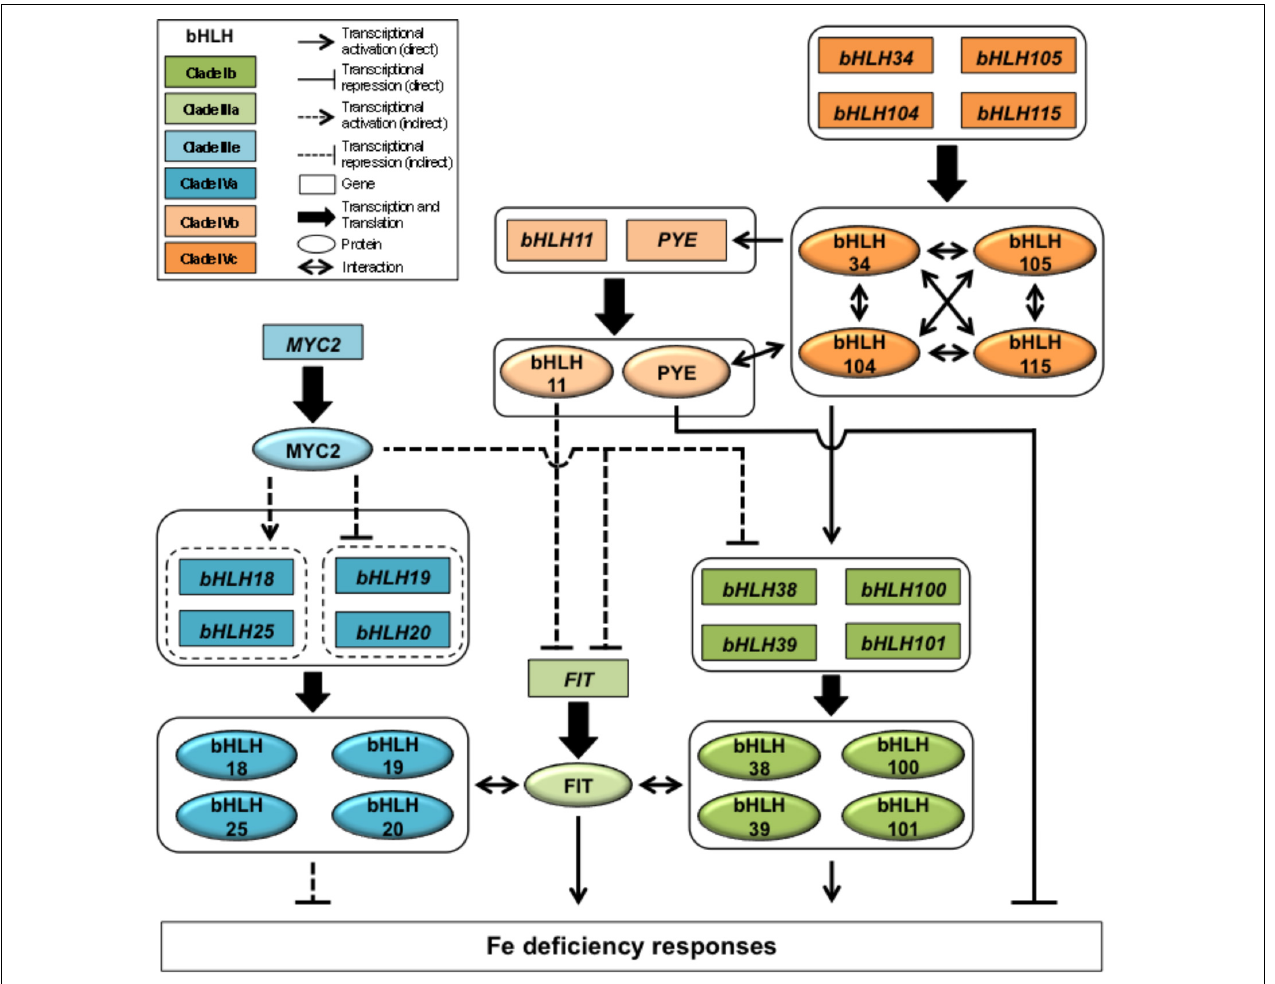
FIGURE 1 | bHLH-dependent transcriptional regulatory network controlling the iron deficiency response in Arabidopsis thaliana